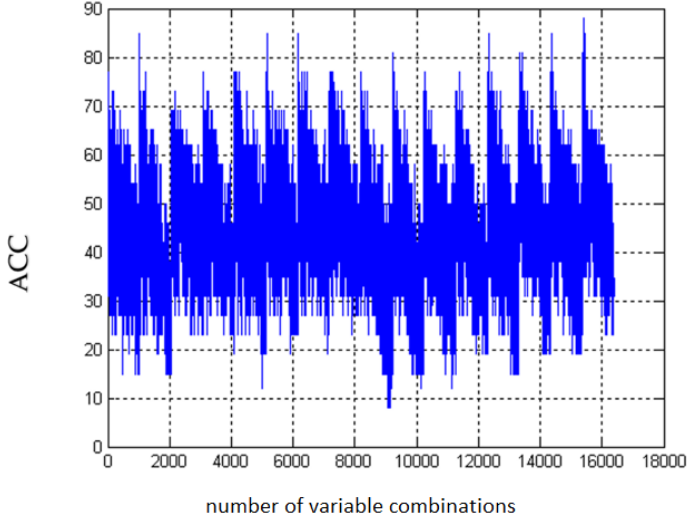
Figure 3. A cumulative graph of ACC value changes for all variable combinations of selected variables (HbA1c, HDL, LDL, TG, ACR, eGFR, glucose, insulin, QUICKI, HOMA-IR, HOMA-S, HOMA-B, and eGDR) with always present vaspin. The number of all analyzed combinations of selected parameters was specified as 2 14 − 1 = 16383 classifications, among which the diagnostic panels with the highest ACC value were selected.